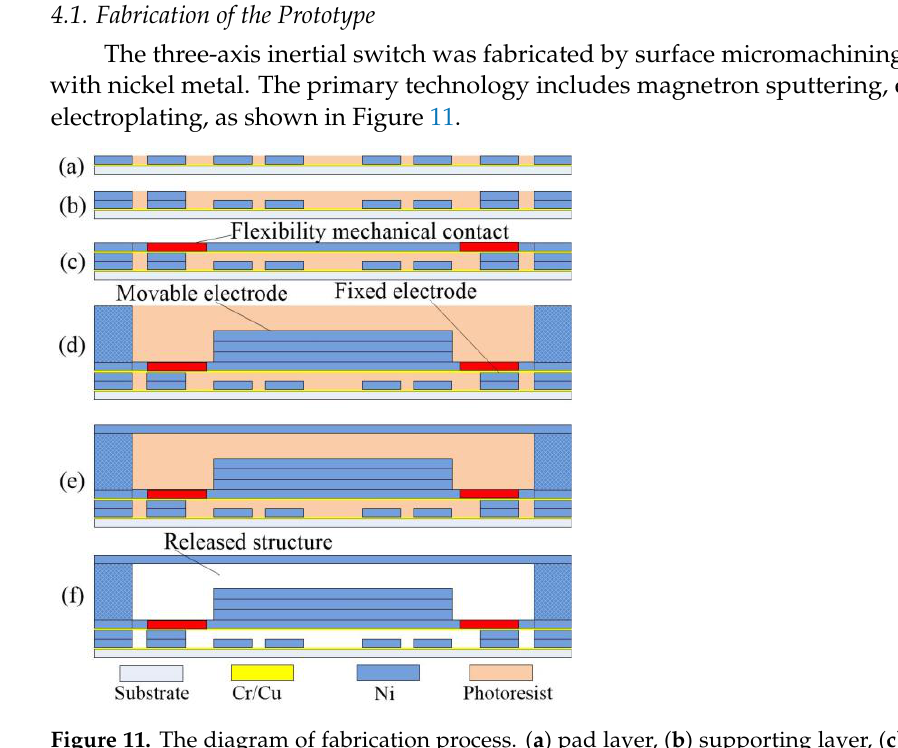
Figure 11. The diagram of fabrication process. ( a ) pad layer, ( b ) supporting layer, ( c ) spring layer, ( d ) proof mass, ( e ) anctilever beam, ( f ) released